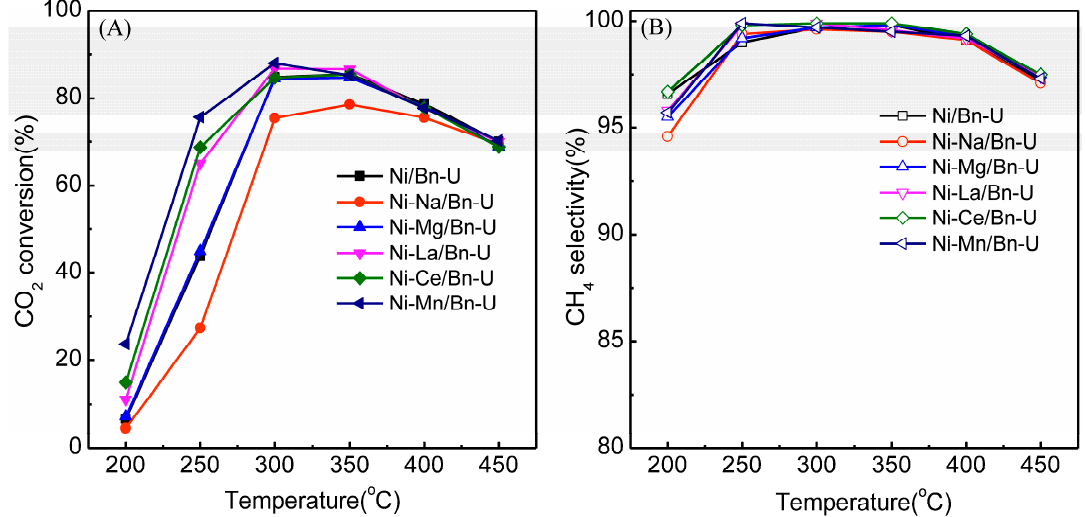
Figure 1. Effects of Ni/bentonite-U catalyst modified with different metals on the CO 2 conversion ( A ) and CH 4 selectivity ( B ). Reaction conditions: atmospheric pressure, V (H 2 )/ V (CO 2 ) = 4, GHSV = 3600 mL · g cat − 1 · h − 1 .